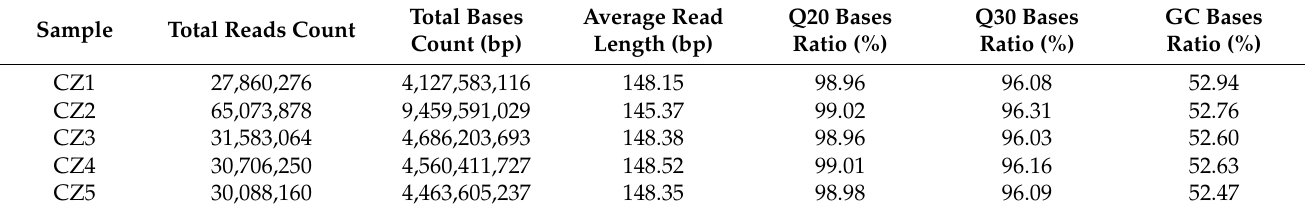
Table 1. Transcriptome data quality statistics.